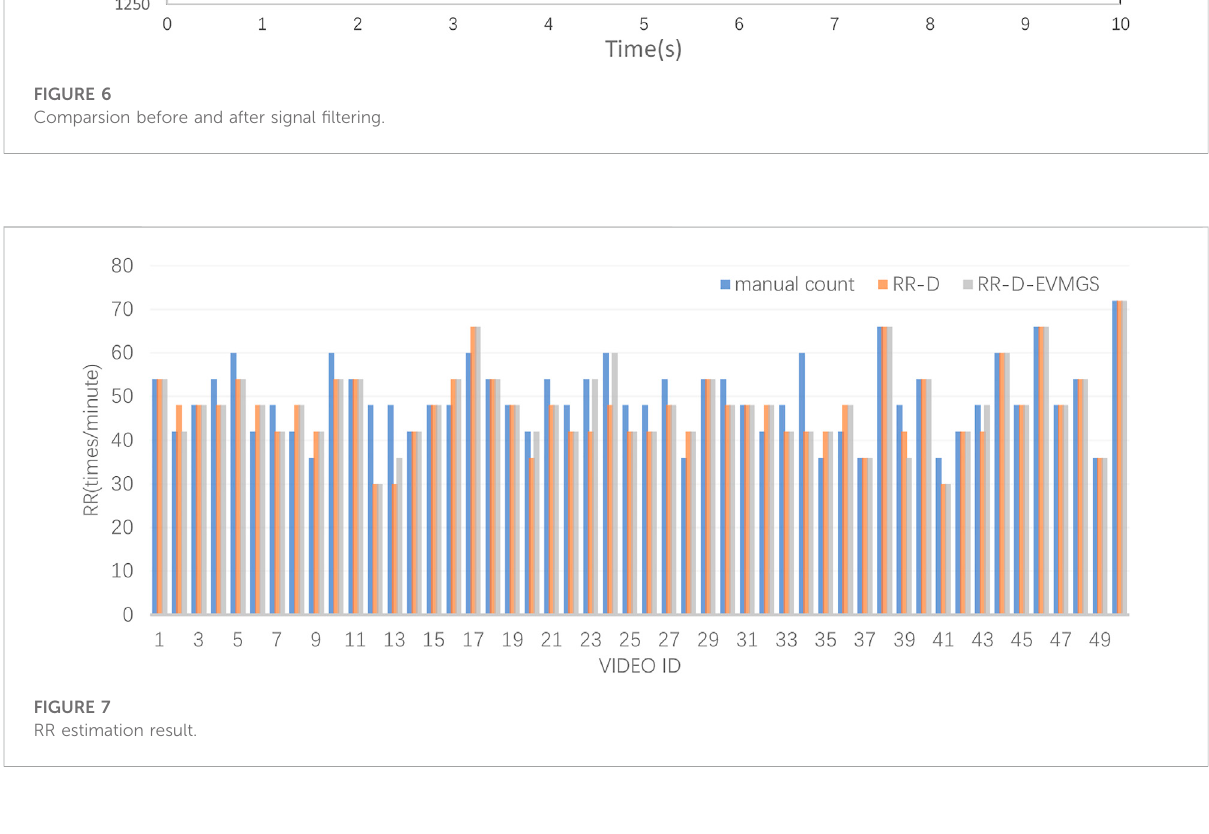
TABLE 4 Test results of RR-D and RR-D-EVMGS.